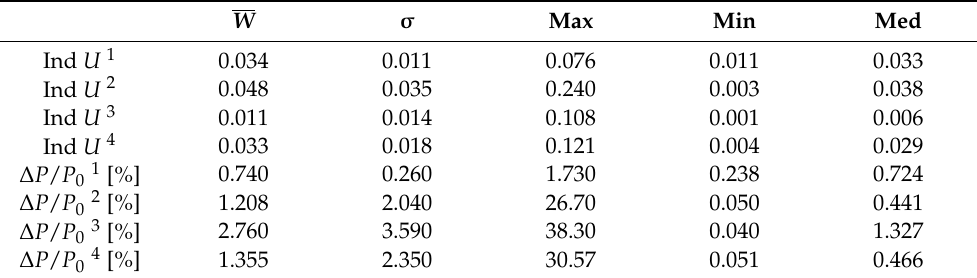
Table 2. Annual changes in the voltage quality and power loss index. W